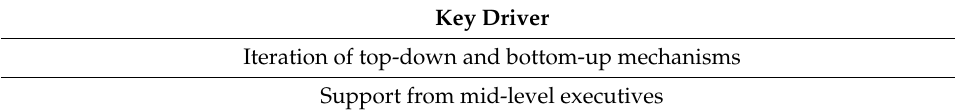
Table 1. Key drivers for formal social units (source: Biresselioglu et al. [28]). Key Driver Iteration of top-down and bottom-up mechanisms